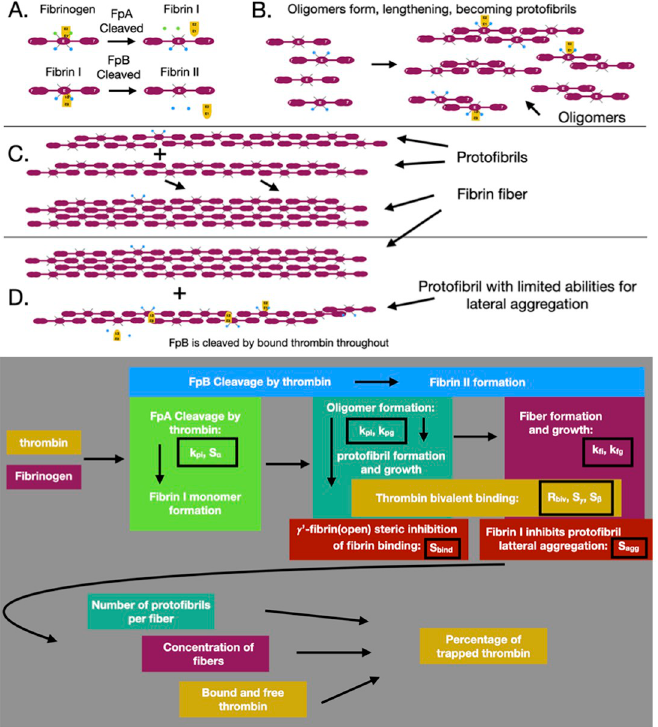
Fig 2. Schematic of the four main stages in the polymerization model. (A) Thrombin forms fibrin I and fibrin II monomers. Thrombin (yellow shape) binds the the E-domain of fibrinogen (purple with blue and green dots), cleaving FpA (green dots), which converts fibrinogen into fibrin I (purple with blue dots). Thrombin binds to the E-domain to cleave FpB (blue dots), converting fibrin I into fibrin II (purple with no dots). (B) Fibrin I and II bind together forming half-staggered chains called oligomers. Fibrin I and II also bind to existing oligomers, increasing them in length. When an oligomer reaches a critical length (11 monomers in length for this study), it becomes a protofibril. (C) Protofibrils aggregate laterally, forming fibers, which are cable-like bundles of protofibrils. Additional protofibrils can bind to an existing fiber, increasing its diameter. (D) As protofibrils and fibers are formed, FpB continues to be cleaved from fibrin I that is incorporated into protofibrils and fibers. Fibrin I is considered to have a limiting effect of lateral aggregation, slowing the process as the ratio of fibrin I to fibrin II increases. The bottom of the figure shows a diagram of the model flow, particularly how key components of the model are connected and which estimated parameters affect each component. The colors in the flow diagram match those in the schematics